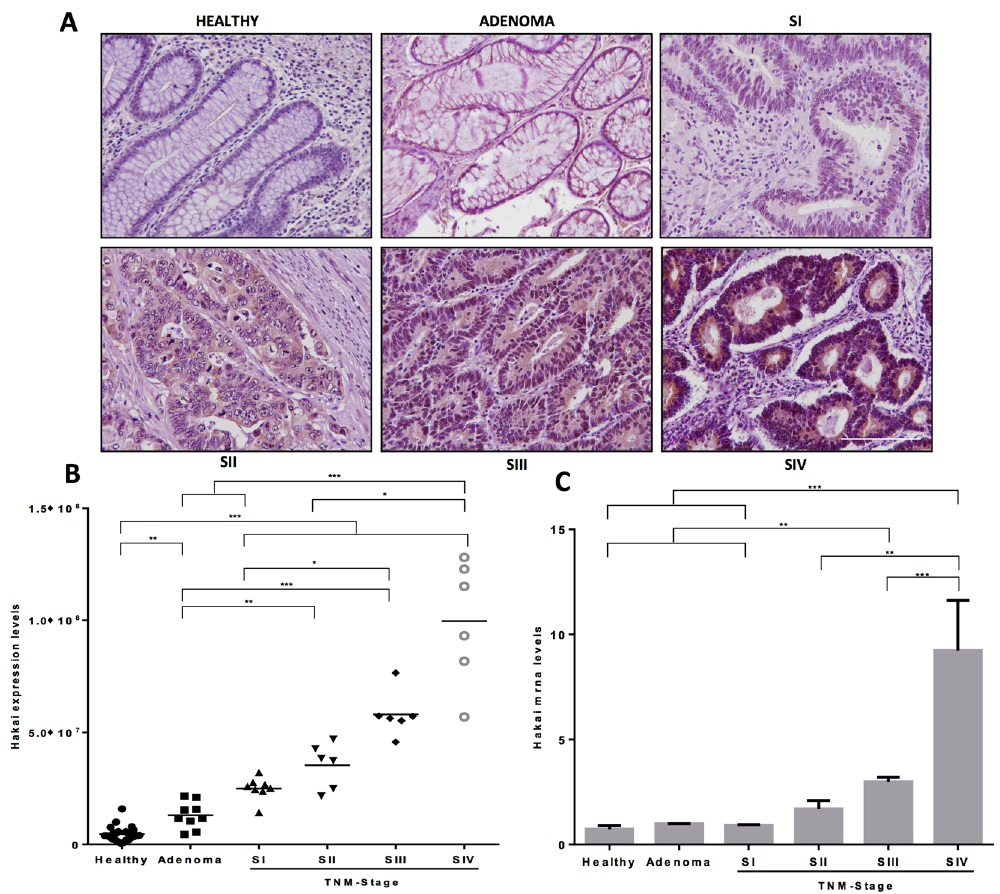
Figure 1. Hakai expression levels in human samples from colorectal cancer patients. ( A ) Representative immunoreactivity of Hakai in normal colonic mucosa, adenoma, and colorectal cancer (TNM stages I-IV). Images were obtained with a 20x objective. Scale bar 125 μ m. (B) Statistical quantification of Hakai staining intensity in epithelial cancer cells at different colon cancer stages and in adenoma and normal colon tissues (normal colonic mucosa, n = 26; adenoma, n = 10; colorectal cancer, n = 20 of all stages). Five photographs of each tissue were quantified. Data are represented as scatter plot. Values are means ± SEM of staining intensity signal scoring per area. Calibration and quantification of the images were performed with ImageJ software. Kruskal-Wallis with Tukey correction test analyses show statistical differences in colorectal cancer (TNM, SI- IV) respect to paired healthy samples ( * p < 0.05; ** p < 0,01; *** p < 0,001). (C) Hakai mRNA expression